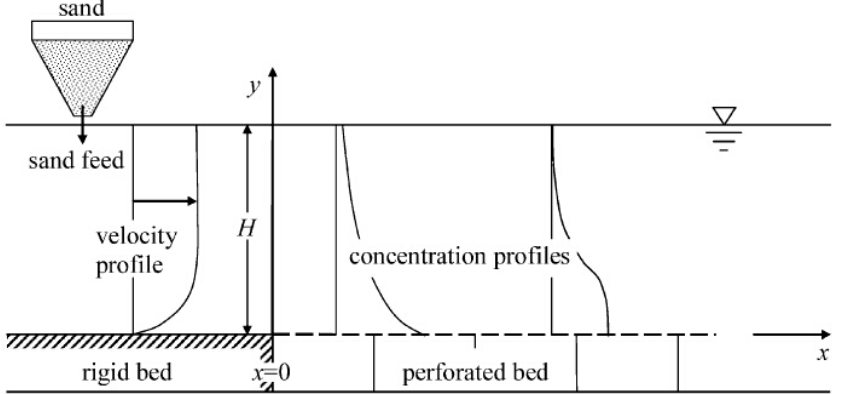
Figure 4. Schematic description of Zero Erosion experiment.